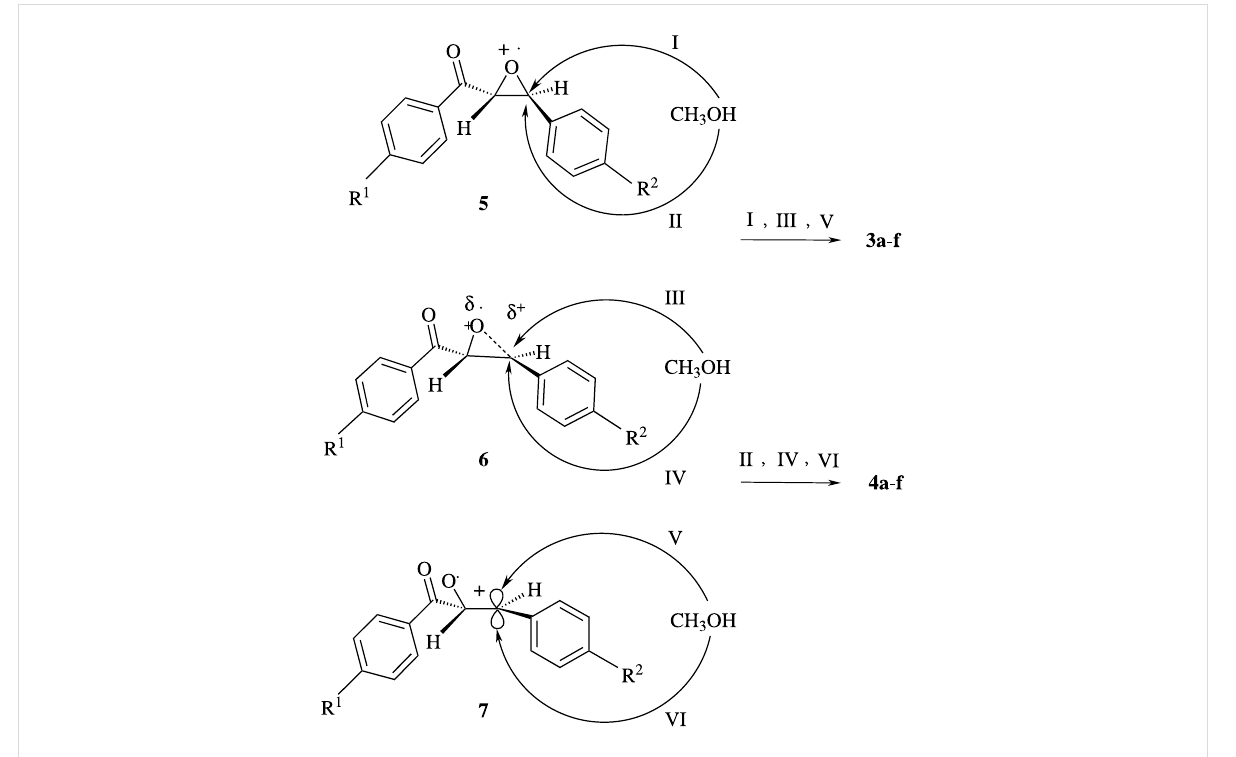
Scheme 2: Possible intermediates involved in the ring opening of